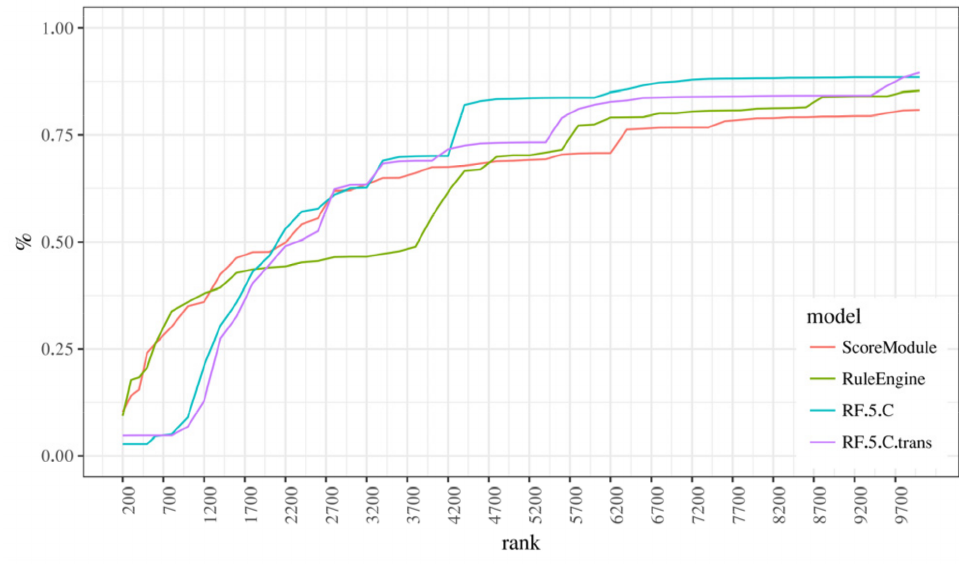
Figure 9. Ranked weighted recall chart for the RF.5.C and baseline models.